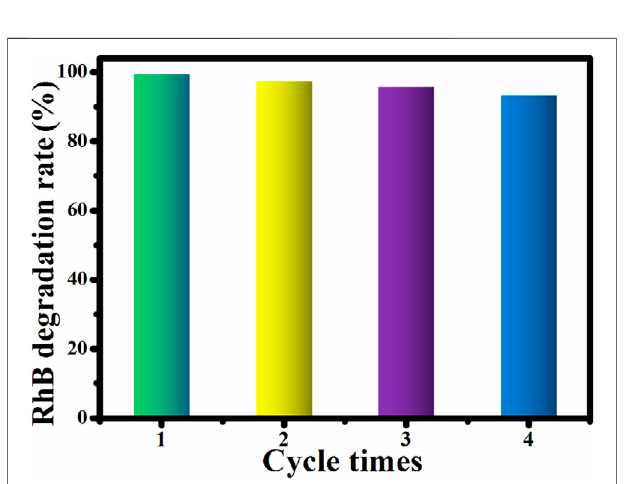
FIGURE 9 | Four photocatalytic degradation cycles of RhB by using Ag/ ZnO under UV light irradiation.